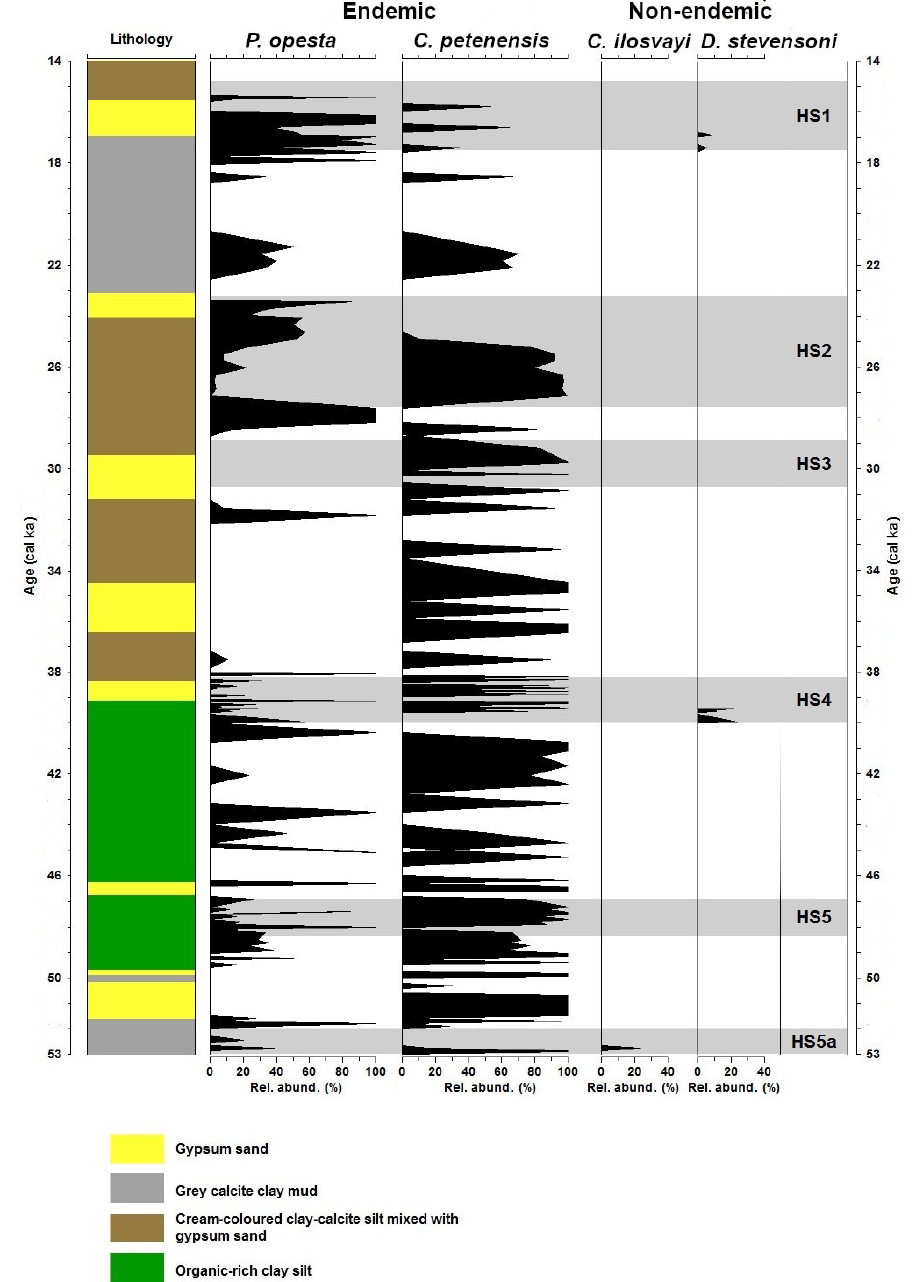
Figure 7. Fossil record of two endemic ( Paracythereis opesta and Cypria petenensis ) and two non-endemic ( Cytheridella ilosvayi and Darwinula stevensoni ) ostracode species during the period 53–14ka. Grey horizontal bars represent temporal extent of Heinrich stadials (HS5a–HS1). Modified from Cohuo et al.